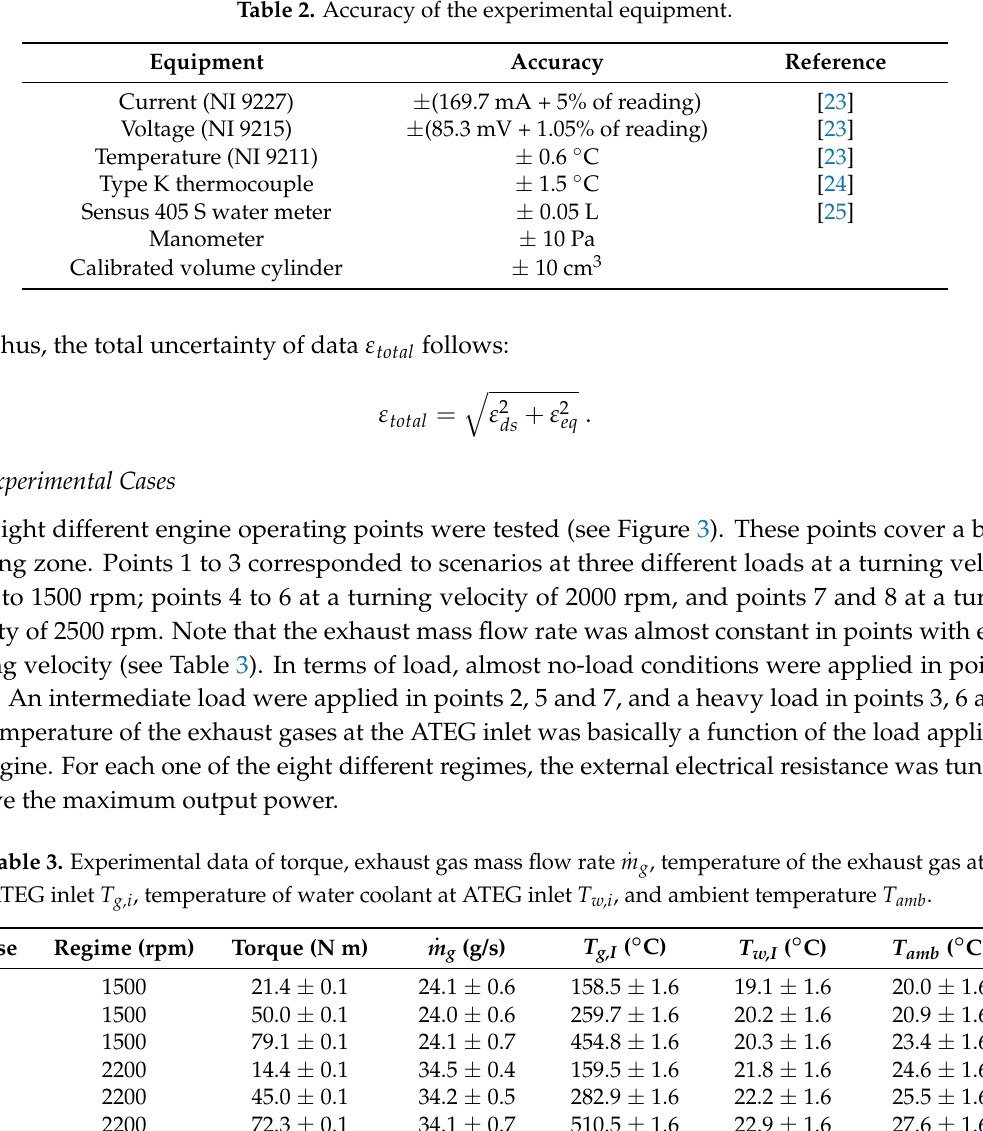
Table 3. Experimental data of torque, exhaust gas mass flow rate